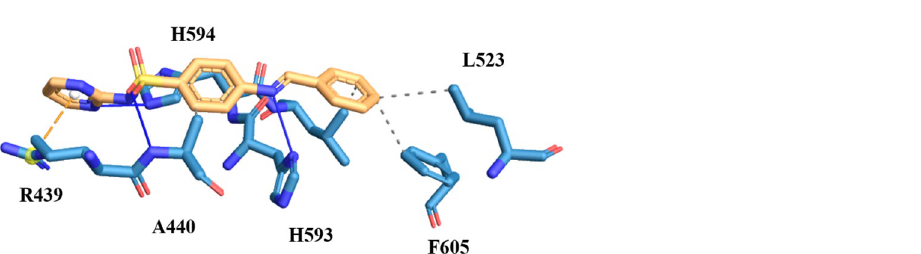
Figure 7. The simulated binding mode of compound 3a in the binding pocket of Jack Bean